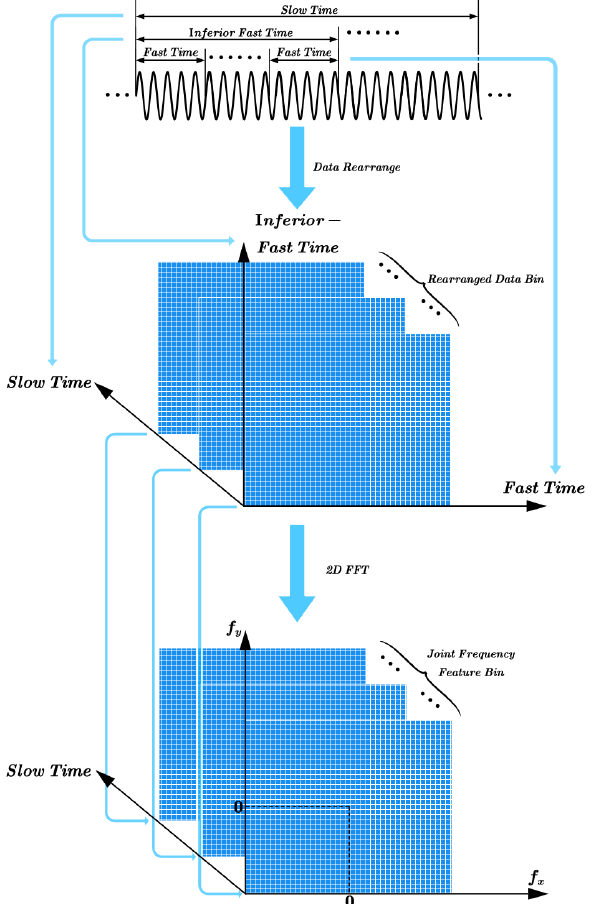
Figure 1. Modulation feature extraction based on